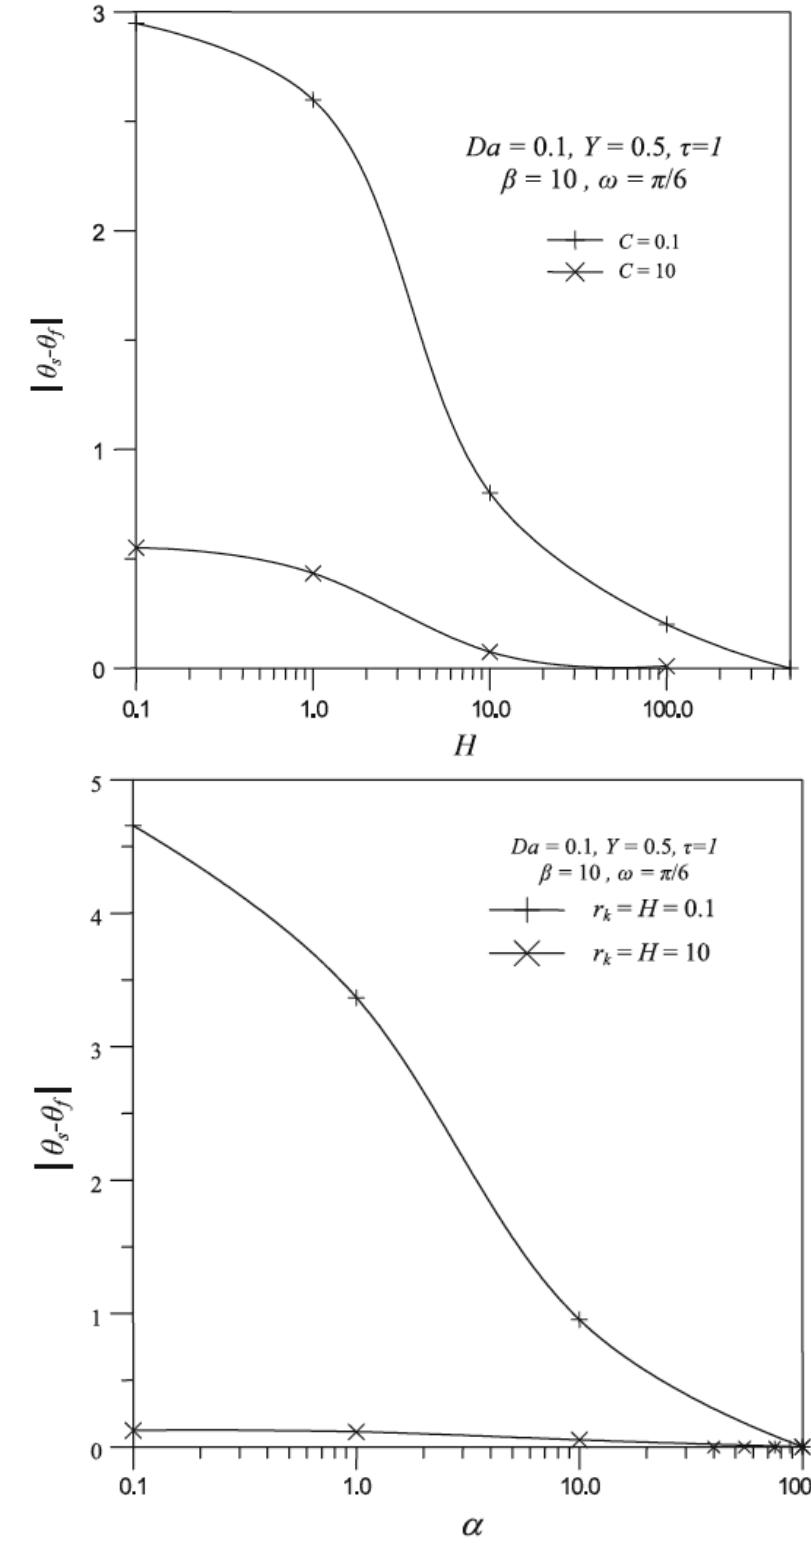
(cid:12) (cid:12) (cid:12) θ s − θ f (cid:12) ) against ( Top ) interfacial heat transfer parame-